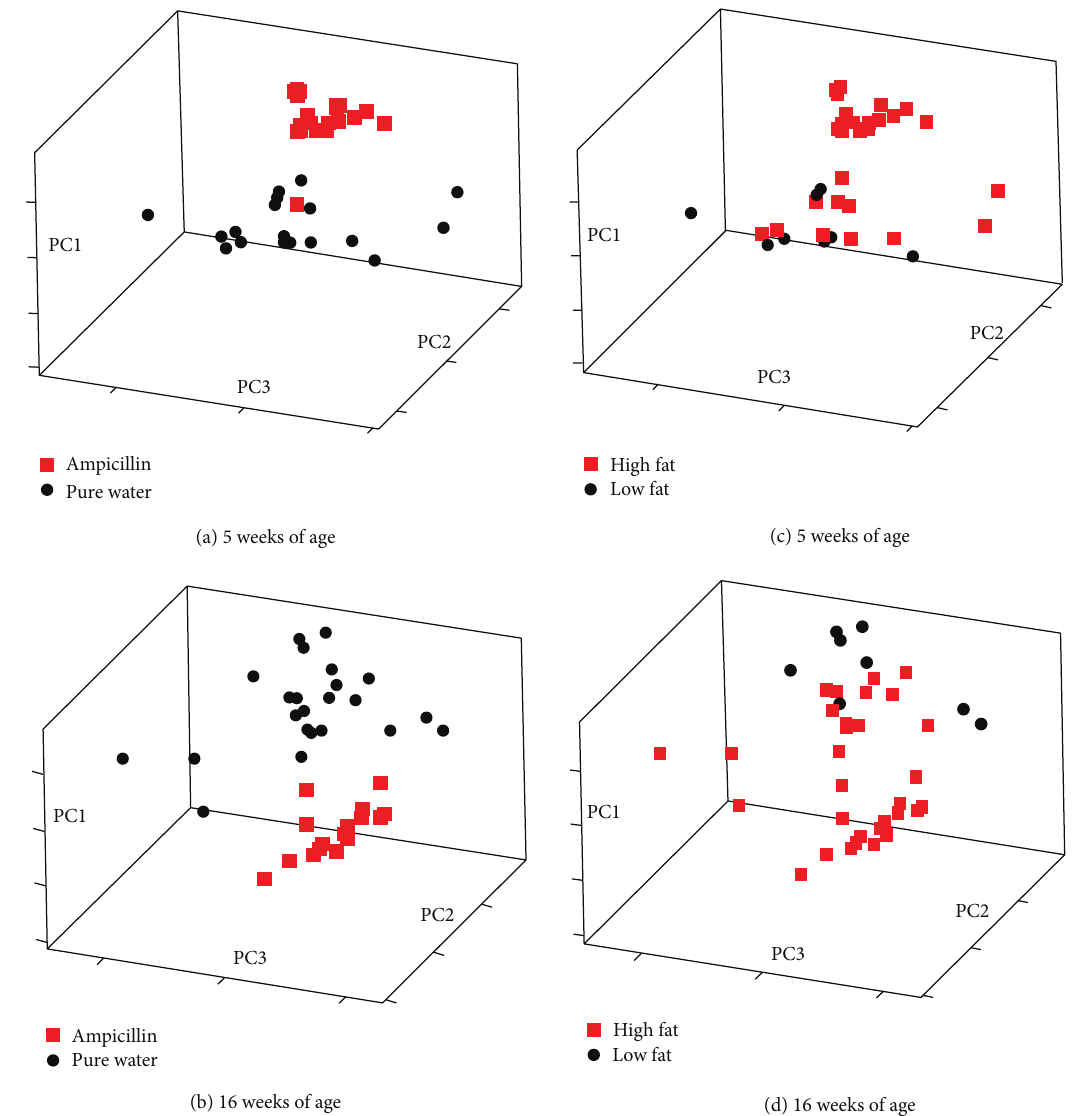
Figure 5: Principal component analysis (PCA) plots of the gut microbiota in diet-induced obese C57BL/6mice treated or nontreated with Ampicillin from birth and until five weeks of age, from 12 to 16 weeks of age, or both. The clustering on all four PCA plots is significant: (a) PC1: 𝑃 = 0.000 , PC2: 𝑃 = 0.001 , (b) PC1: 𝑃 = 0.000 , (c) PC1: 𝑃 = 0.000 , PC3: 𝑃 = 0.05 , (d) PC1: 𝑃 = 0.000